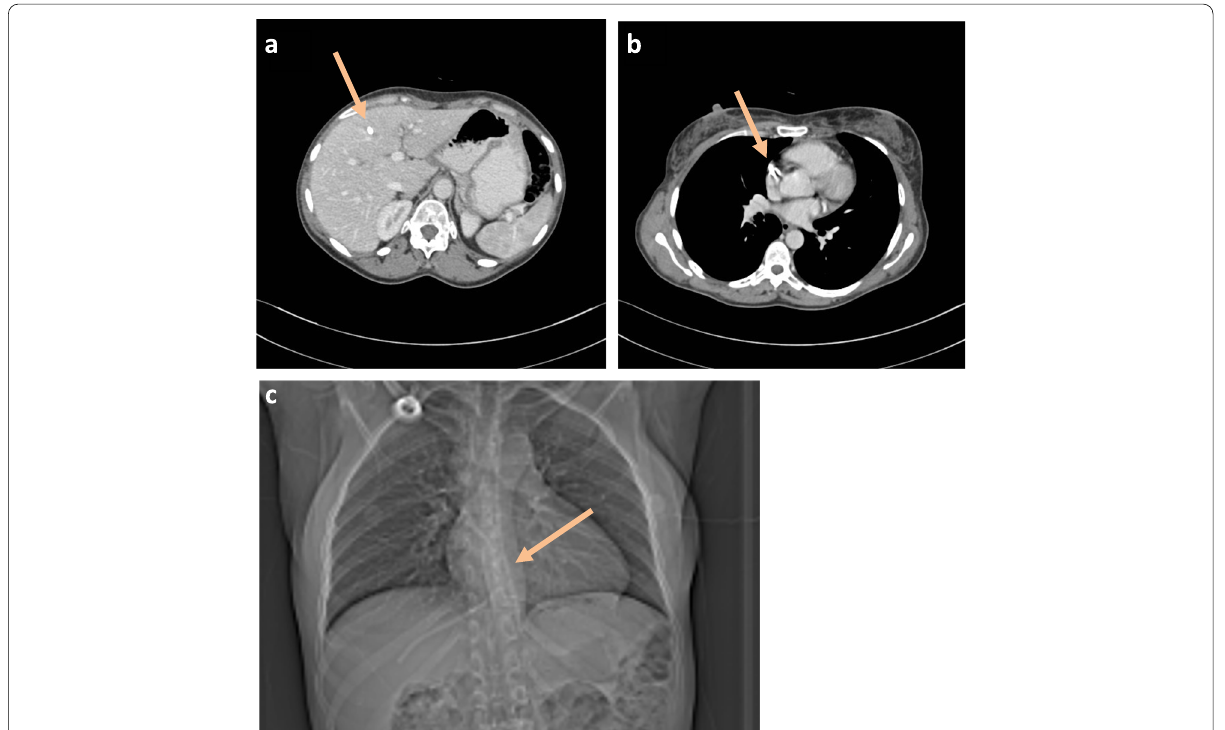
Fig. 1 Contrast enhanced axial images of the chest and abdomen demonstrating the distal tip of the catheter fragment in the middle hepatic vein ( a , orange arrow) and proximal tip in the right atrial appendage ( b , orange arrow). Scanogram of the CT chest and abdomen demonstrating the catheter fragment ( c , orange